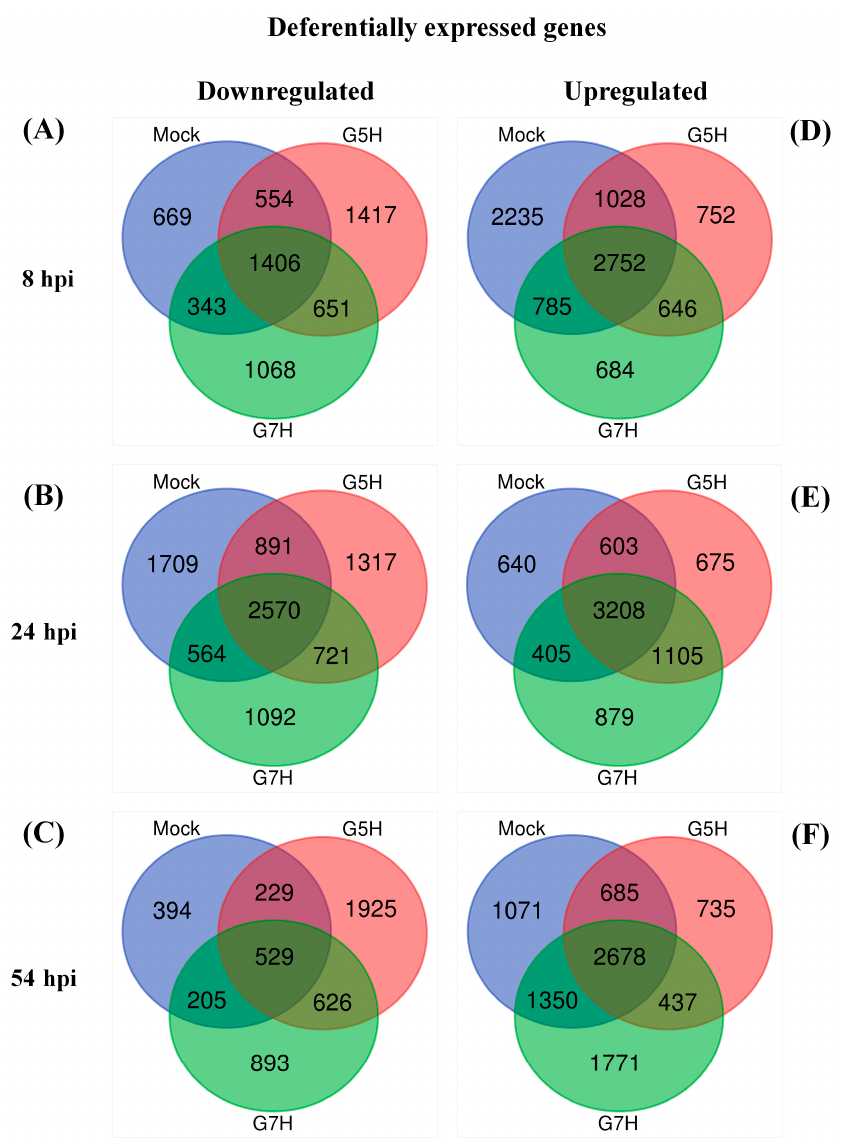
Figure 1. Venn diagrams illustrating the clustering of the differentially expressed genes (DEGs). The diagrams show up- and downregulated DEGs from soybean plants (cultivar L29 carrying the Rsv3 ER gene) that were mock inoculated, infected with SMV avirulent G5H, or infected with SMV virulent G7H. DEGs were subjected to calculation of intersection using Venn diagrams: Downregulated DEGs at 8 hpi ( A ), 24 hpi ( B ), and 54 hpi ( C ). Upregulated DEGs at 8 hpi ( D ), 24 hpi ( E ), and 54 hpi ( F ). DEG lists were obtained from RNA-seq data using EXPath Tool by comparing the expression levels of healthy plants to those in mock plants and G5H- and G7H-infected plants at different time points.